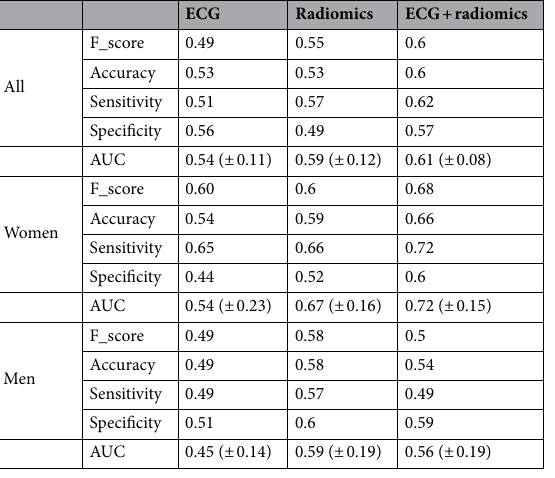
Table 8. Average performance of the models when the AF patients have a normal sinus rhythm and a normal ECG. The standard deviation is indicated in parenthesis.